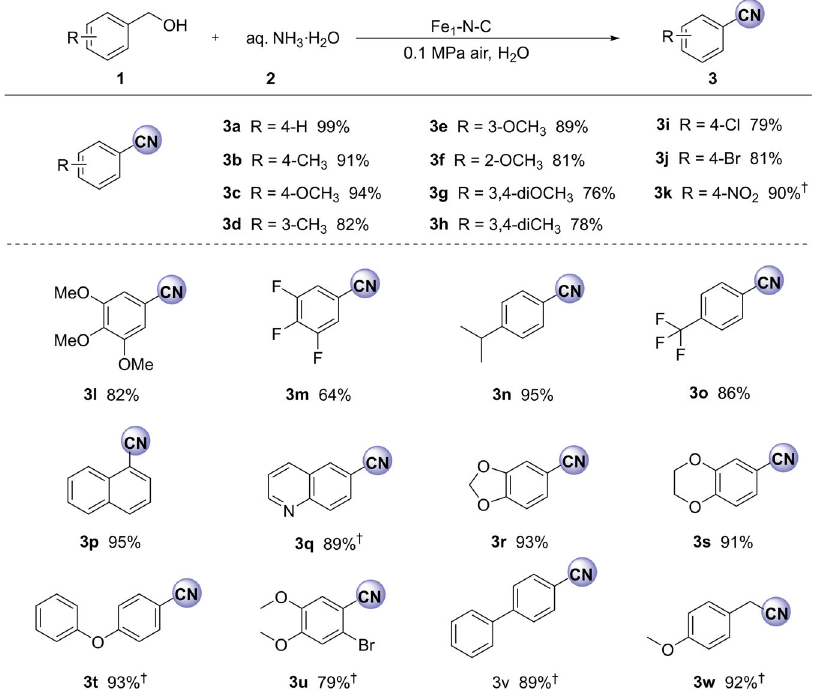
Fig. 5 Ammoxidation of alcohols catalyzed by Fe 1 -N-C. Reaction conditions: alcohol (0.2 mmol), 20 mg catalyst (3.9 mol% Fe), aq. NH 3 ·H 2 O (150 mg, 25 – 28 wt%), 35 °C, 0.1 MPa air, 1.5 mL H 2 O, isolated yields. †